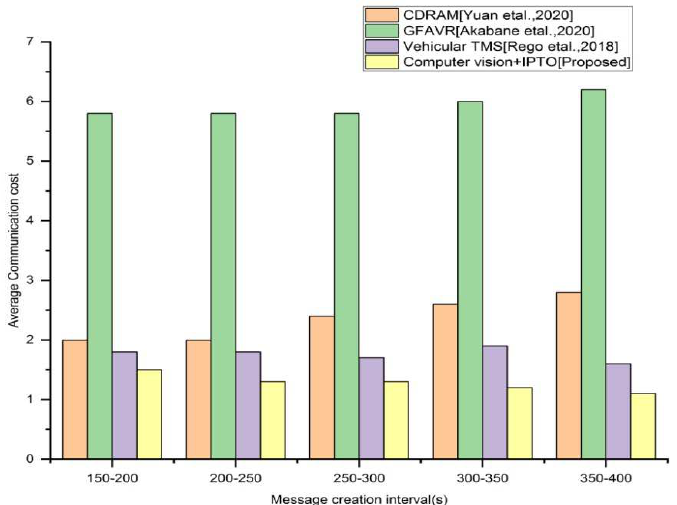
Figure 5. Average communication cost vs. different message interval for the existing and proposed method.